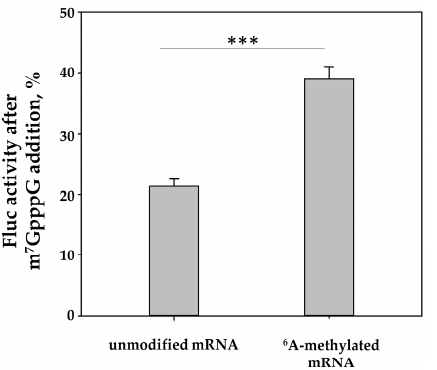
Figure 4. The translation of methylated mRNA shows lower sensitivity to the cap-analog-induced inhibition of cap-dependent translation. C + A + Firefly luciferase reporter mRNA carrying the beta-globin 5 ′ UTR (0.15 nmol) was translated in HEK293T cell extract with or without a cap analog (0.1 mM). The reaction mixture was incubated for 60 min at 30 °C before the determination of Firefly luciferase activity, which was measured as 100% with no cap analog added. The results of three independent experiments are presented. Bars are 2 standard deviations. A two-tailed Student’s t-test was used to estimate the statistical significance; *** p < 0.001. The absolute values of luciferase activity are plotted in Supple- mentary Figure S2.